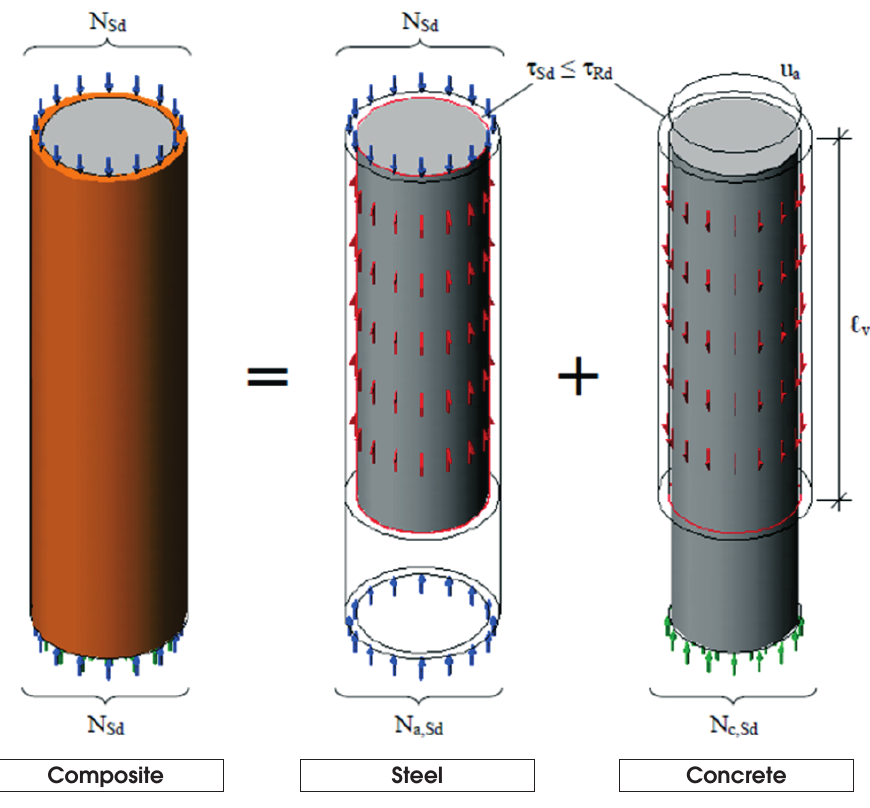
Composite Steel Components of loads and geometric properties to calculate the shear stress at the interface. Source: [4]